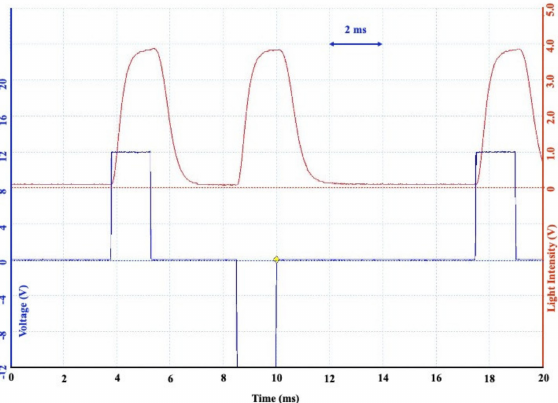
Figure 8. Light-throughput dynamic behavior of the non-uniformly stacked SSD-LC panel for a linearly polarized incident beam.